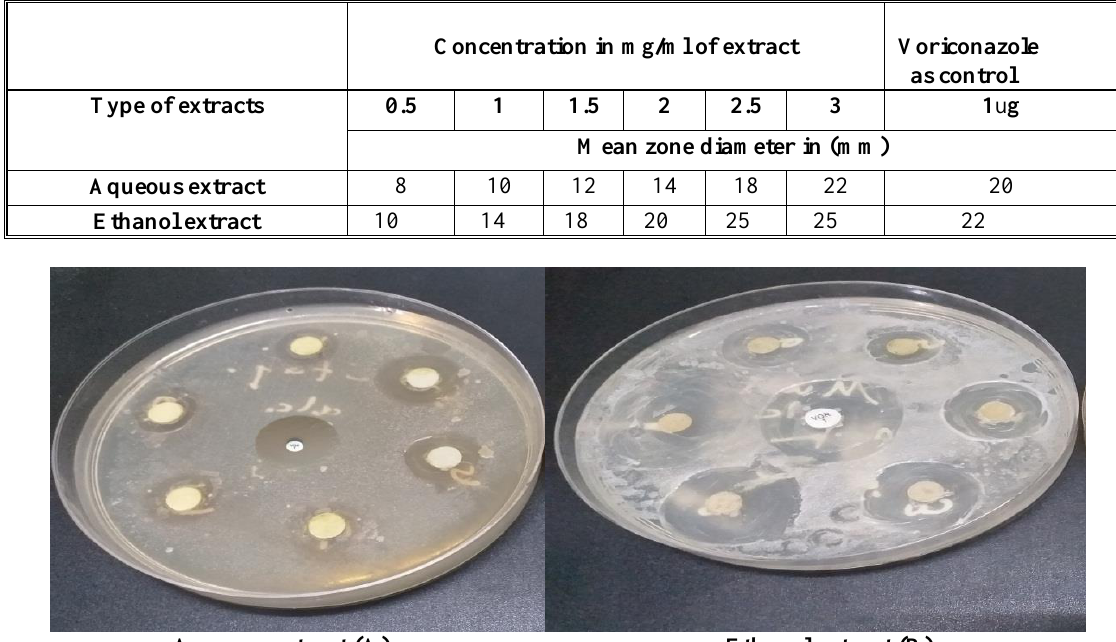
Figure 2. The susceptibility test of Ginkgo biloba extracts against C. albicans. Biofilm formation